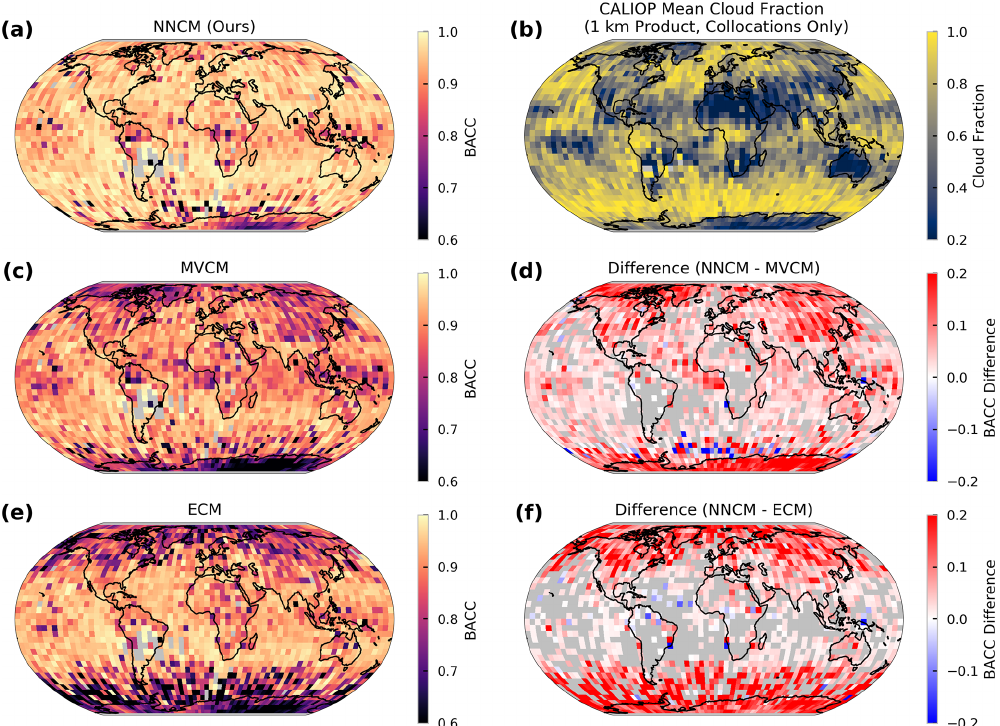
Figure 8. Same as Fig. 7 but all using BACC instead of ACC. Panel (b) has been replaced with the 1km CALIOP cloud fraction computed from the VIIRS and CALIOP